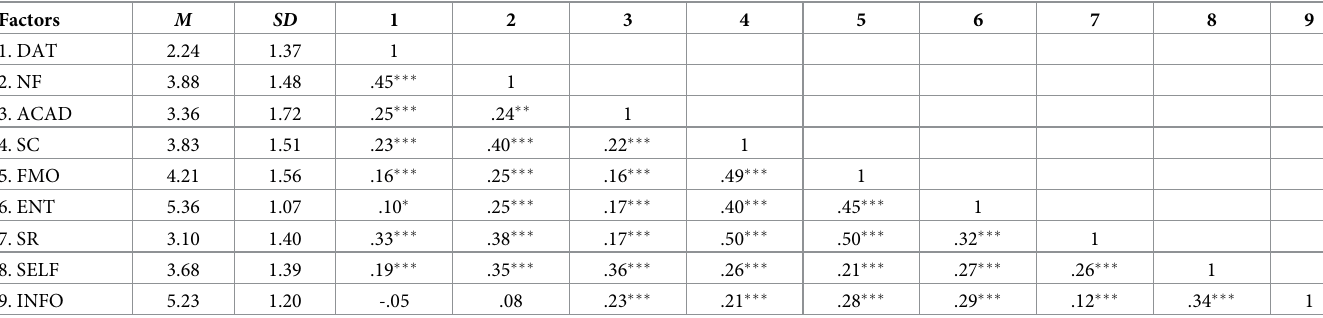
Table 6. Descriptive statistics and correlations among the SMU-SNS factors in the